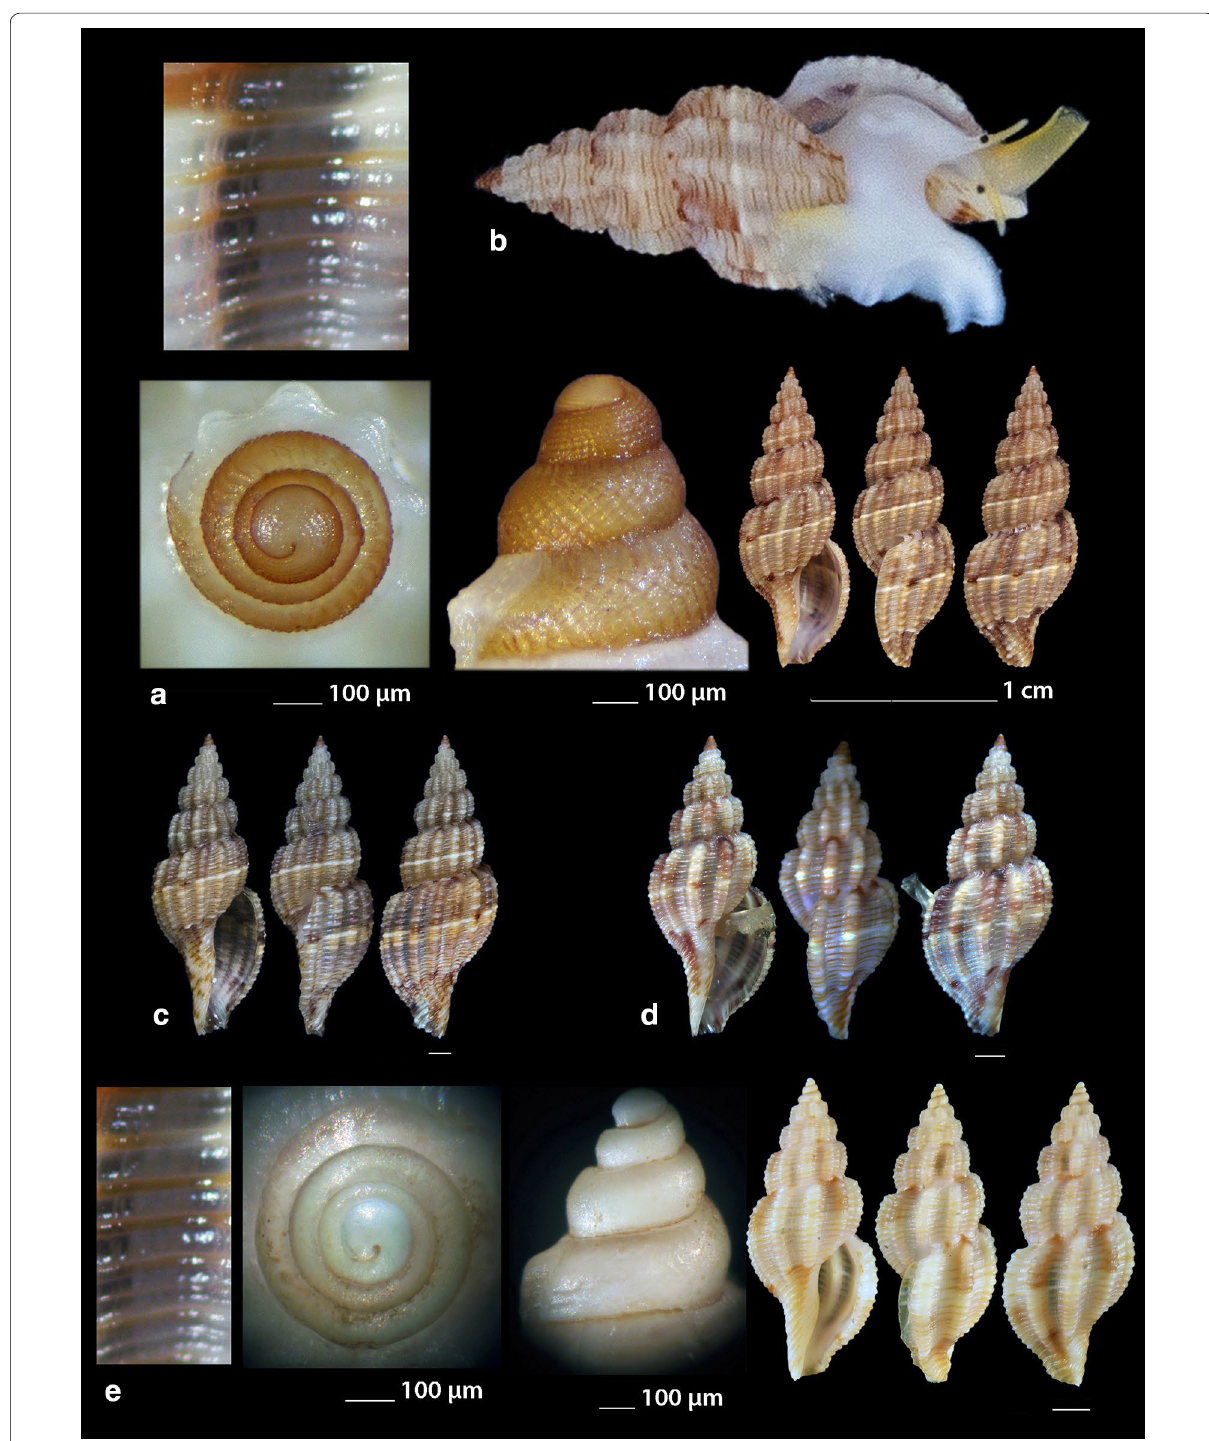
Fig. 18 a – e Raphitoma villaria , b live specimen, e specimen with unusual protoconch. Bar